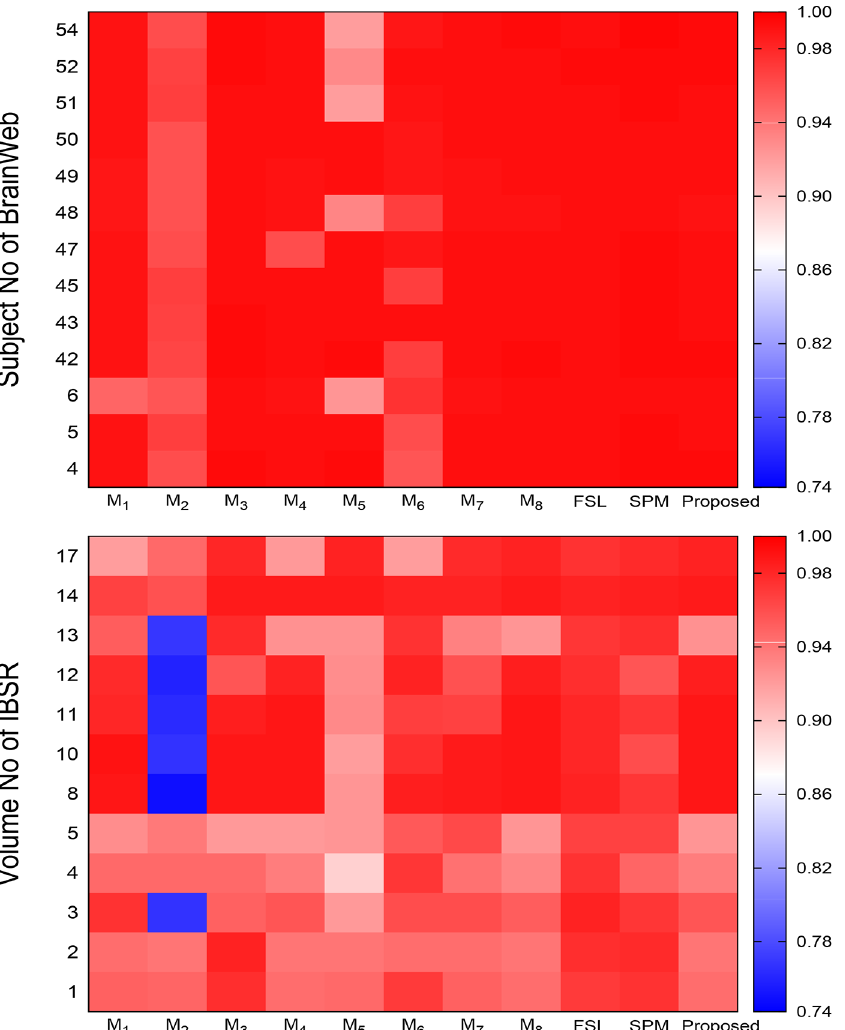
Fig 11. Heat maps obtained by different methods with respect to specificity.